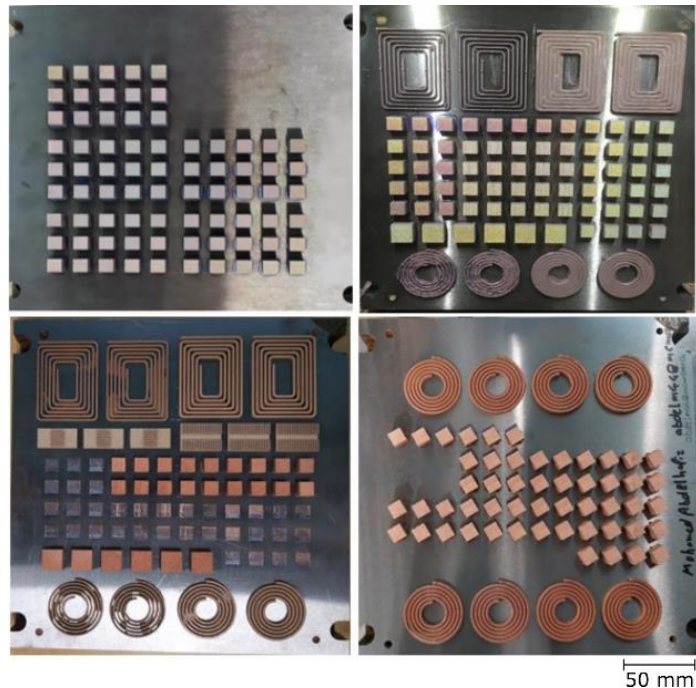
Figure 2. As-built samples arranged before separation from the substrates.